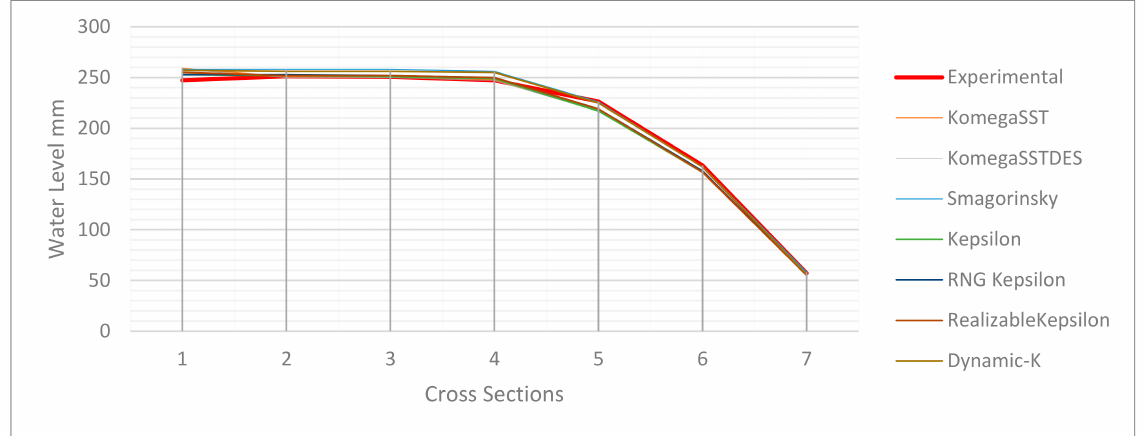
Figure 4. Comparison of experimental water level results (obtained with the average measuring error of 1.93–2.58%) with the numerical simulation results for the discharge of 10